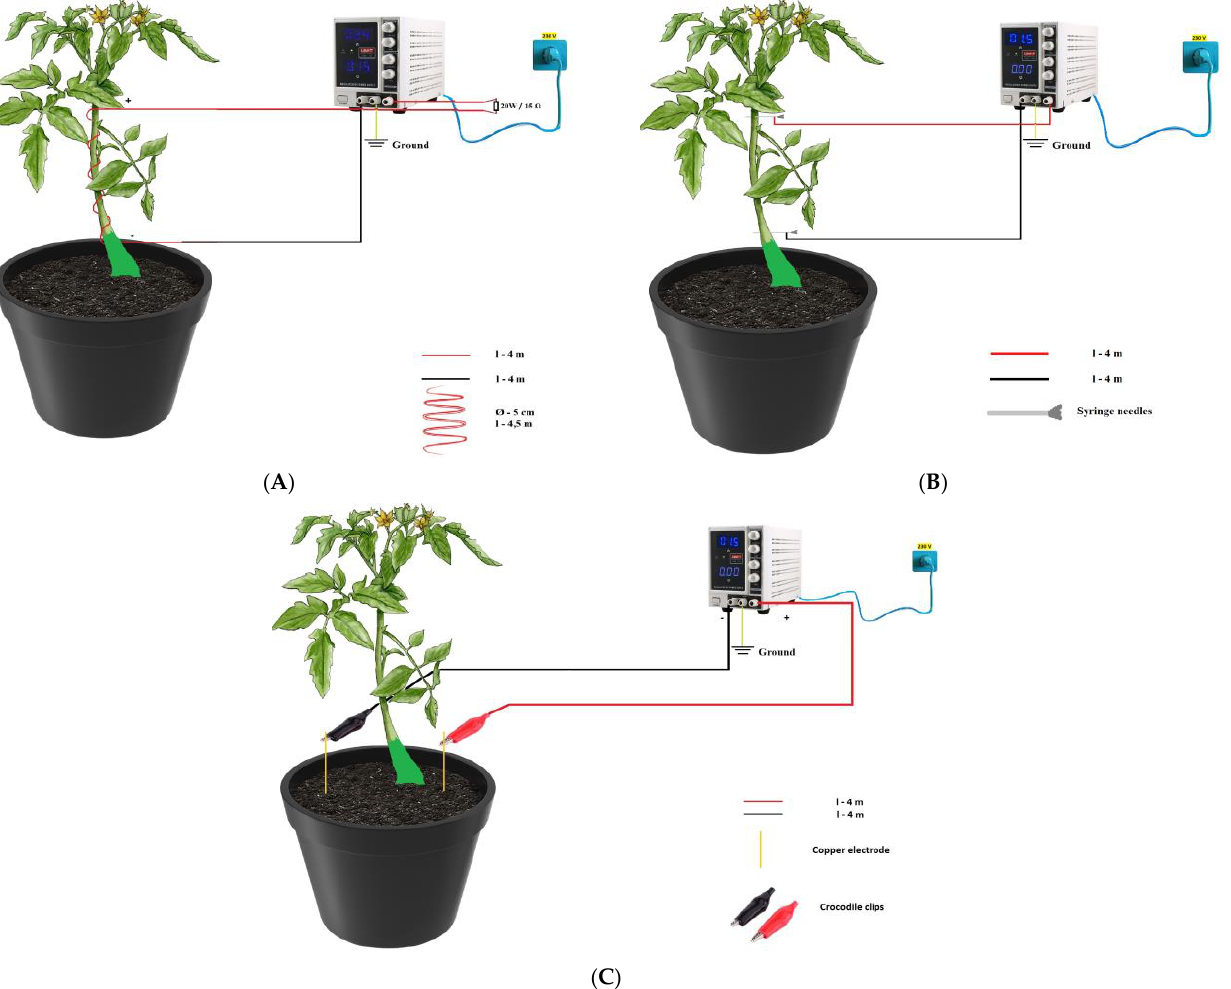
Figure 1. The electrical schematic diagram used to provide currents of different intensities to tomato plants (( A ) = electrical conductor with a length of 4.5 m, arranged in the form of a spiral with a diameter of 5 cm. The DC power applied was 0.15, 0.30, 0.45 A; ( B ) = syringe needles that crossed the plant stem, inserted in two points: in the apical area, and at the base of the stem. The DC power applied was 1.5 V, DC (polarity); ( C ) = two copper electrodes inserted in the soil using crocodile clips (soil version). The DC power applied was 1.5 V.).